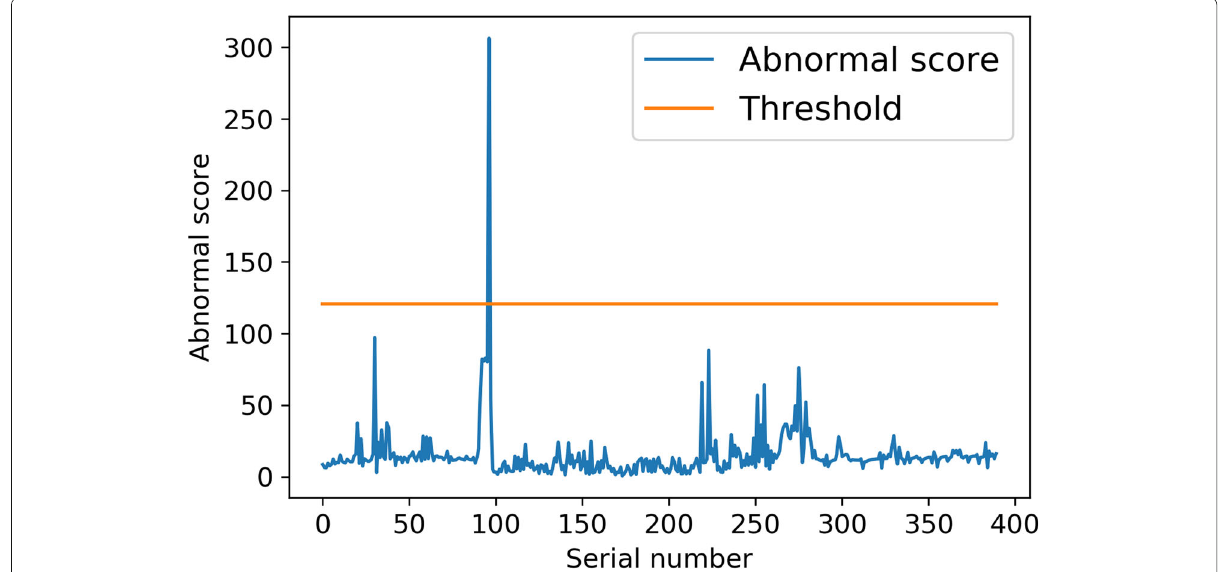
Fig. 9 Triggering effect of latitude change on the average threshold of all